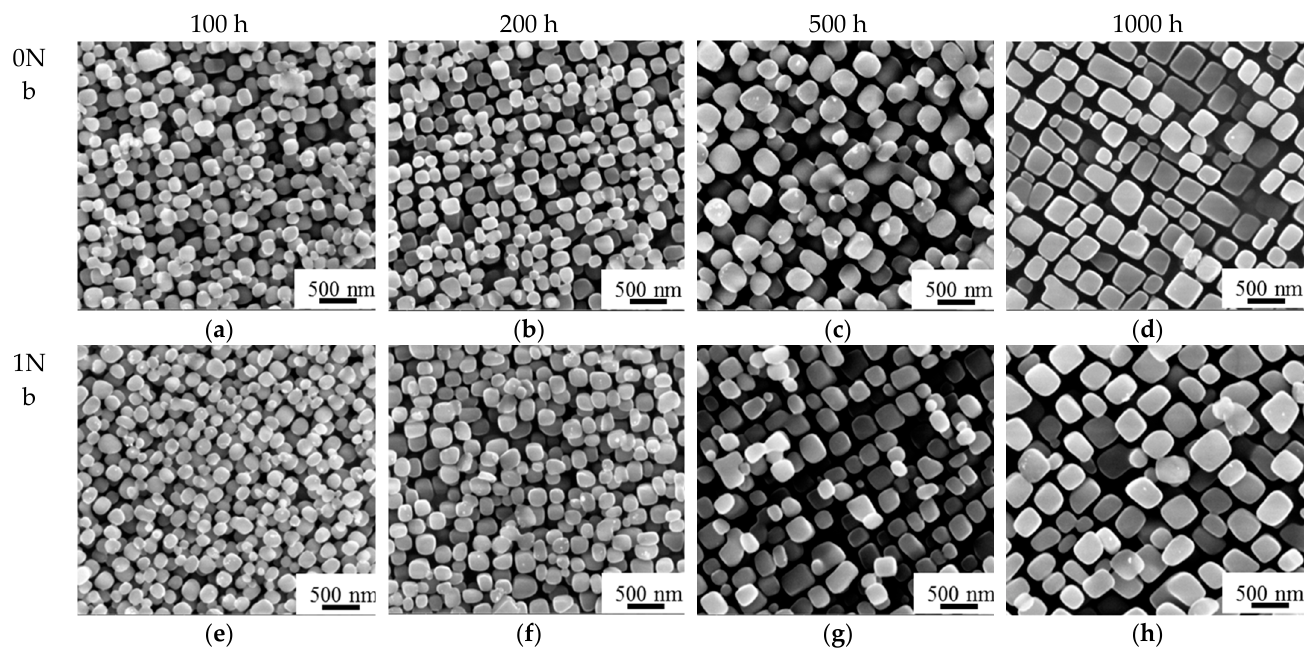
Figure 5. ( a – h ) SEM morphology of γ´ of 0Nb and 1Nb during long-term exposure at 800 °C. Volume fraction and size of γ’ were quantitatively analyzed using high-resolution SEM images. For each exposure time, at least six micrographs were randomly selected and used to measure the γ’ fraction and γ’ phase particle size. The results shown in Figure 6 suggest that with increasing exposure time, the average γ’ size of two alloys increased constantly where faster increment occurred in 1Nb alloy. Meanwhile, the γ’ volume fraction of the 1Nb alloy increased slightly while that of the 0Nb alloy was almost a constant. The γ’ content of the 1Nb alloy is about 4% higher than that of 0Nb, as Nb replaced Al and Ti in γ’ and decreased the solution of Al and Ti in the γ matrix, which facilitated the formation of γ’ [13].